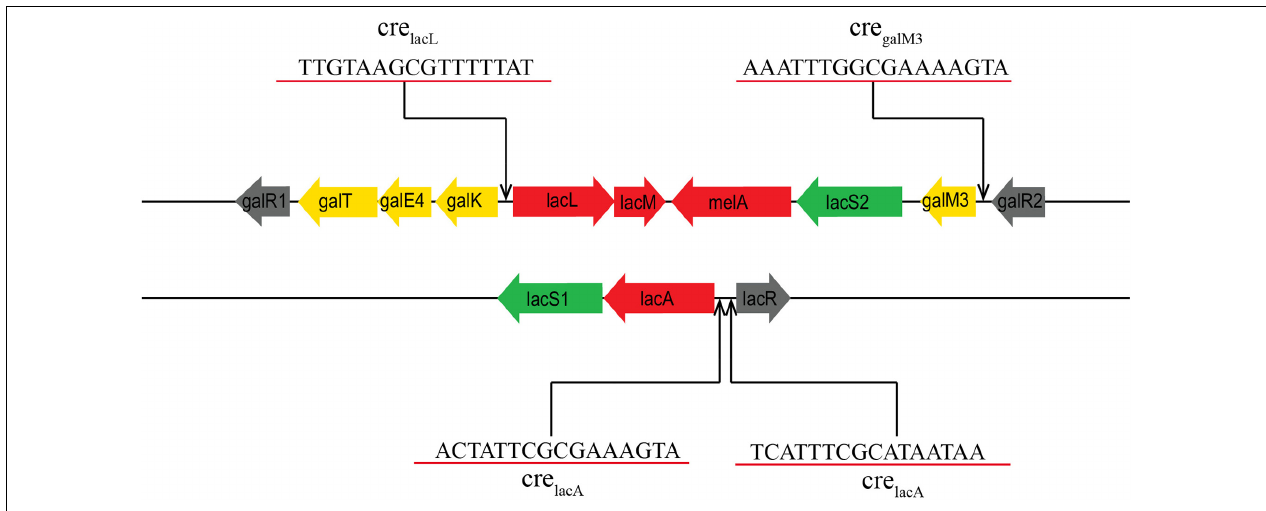
FIGURE 7 | Prediction of the potential cre sites in the gal and lac clusters of L. plantarum ST-III. Putative functions are indicated by color: carbohydrate permease (green), transcriptional regulators (black), glycoside hydrolases (red), Leloir pathway (yellow). Putative cre sites are underlined in red.